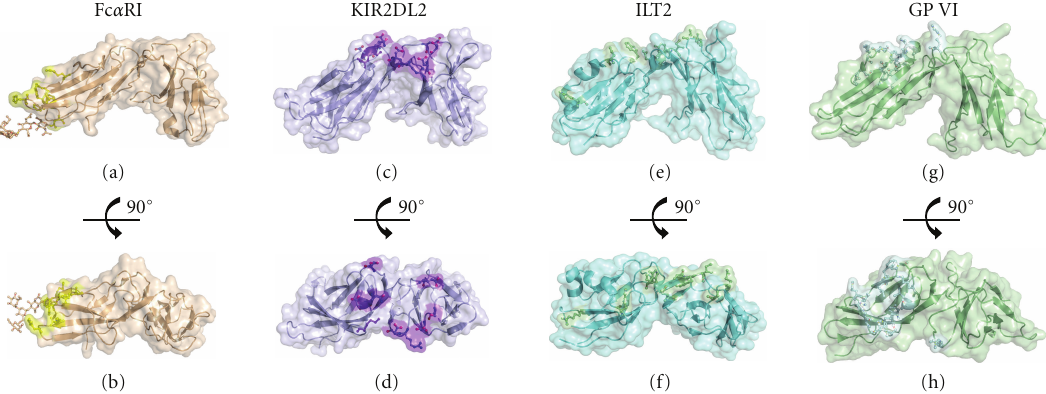
Figure 5: Structures of NKp46 homologous proteins ((a), (b)) Fc α RI, ((c), (d)) KIR2DL2, ((e), (f)) ILT2, and ((g), (h)) GP VI shown in cartoon representation with transparent surface also shown. The known ligand binding residues of these molecules are given in ball and stick representation with the surface of these amino acids also highlighted. KIR binding to MHC molecules utilizes a number of residues found in the AB, CC (cid:3) , EF loop regions of D1, the GA hinge region between D1 and D2, and the BC loop and FG loop regions of D2. ILT-2 uses residues located in the C strand, the CE loop region, EF loop region, and G strand of D1 while also using residues located in the BC loop region of D2. GP VI utilizes residues in the CC (cid:3) loop, C strand, CE loop, E strand, EF loop, and F strand of D1 while also using the FG loop region of D2. CD89 uses residues from the BC loop, C (cid:3) strand, C (cid:3) E loop, and the FG loop of D1 in a side-on mechanism of binding in contrast to the other homologous proteins which all utilize the membrane distal face of the receptor for ligand binding. The lower panel shows the respective molecules in an “above-cell view” orientation which also highlights their ligand binding sites.